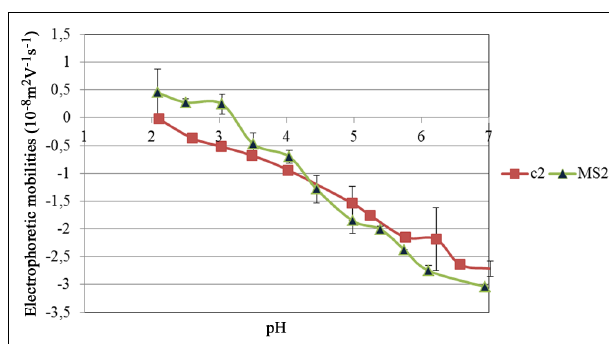
FIGURE 3 |The electrophoretic mobility of bacteriophage MS2 and c2 as function of pH in phosphate buffer.